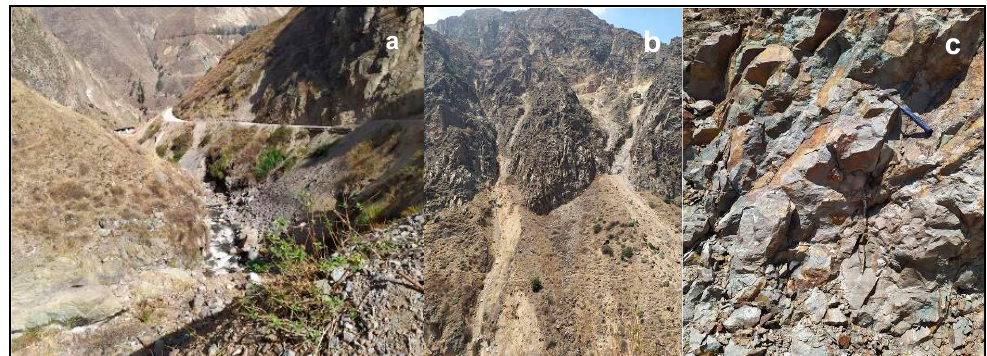
Figure 3. Local geology in Tamboraque area, Parac watershed.